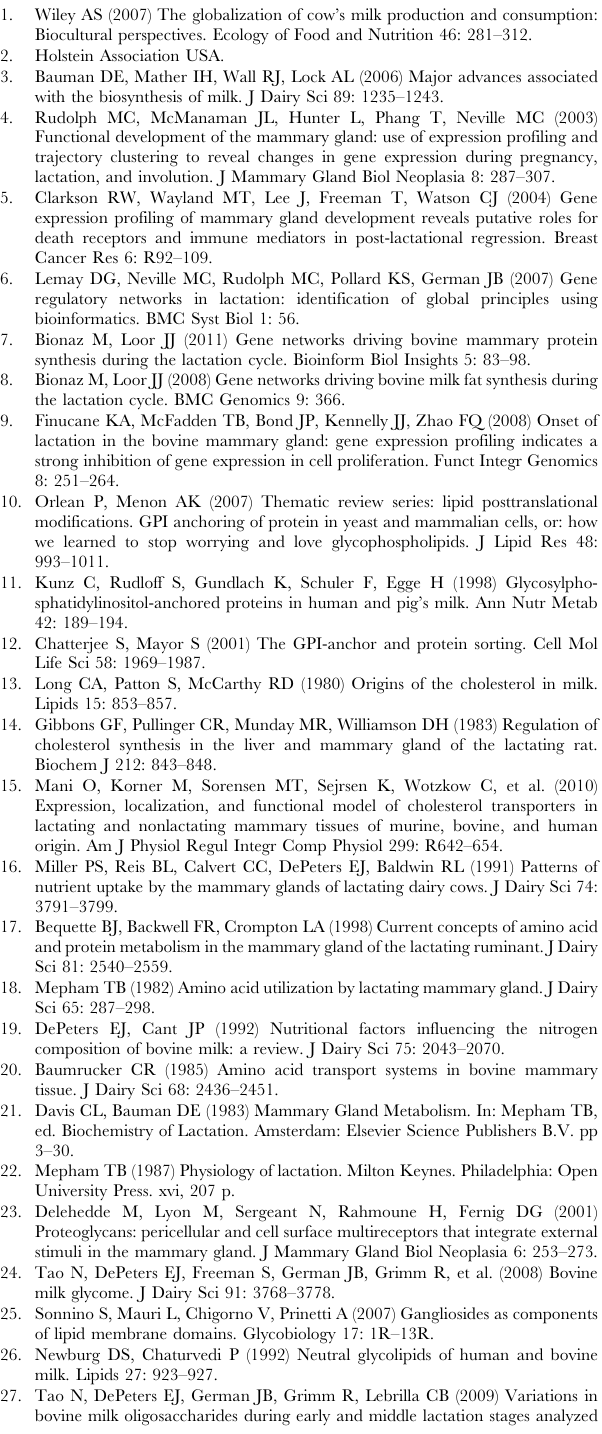
File S5 Tabulated results of microarray vs.